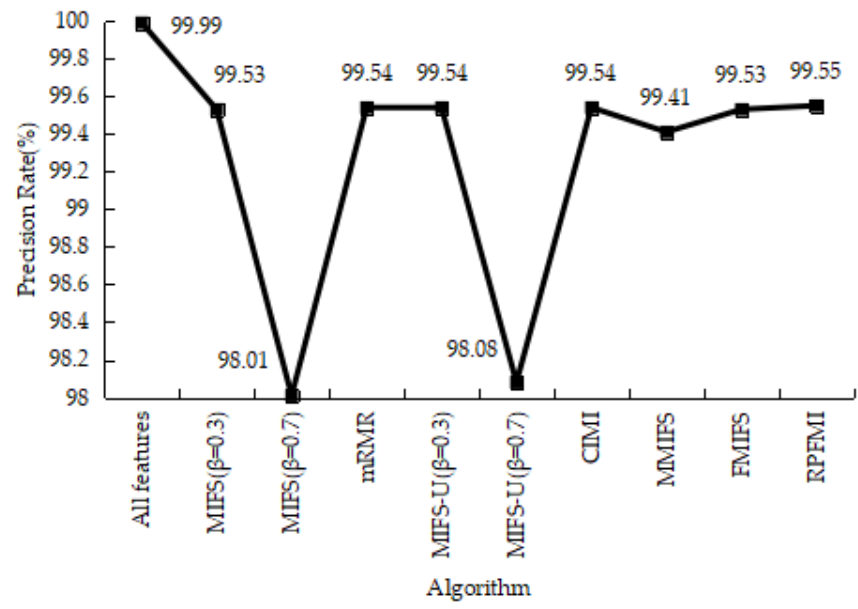
Figure 3. False Positive Rate on the DOS test data.